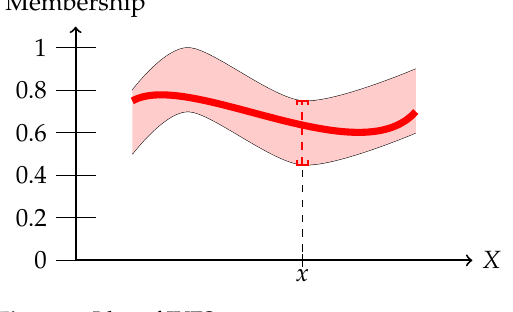
Figure 1. Idea of